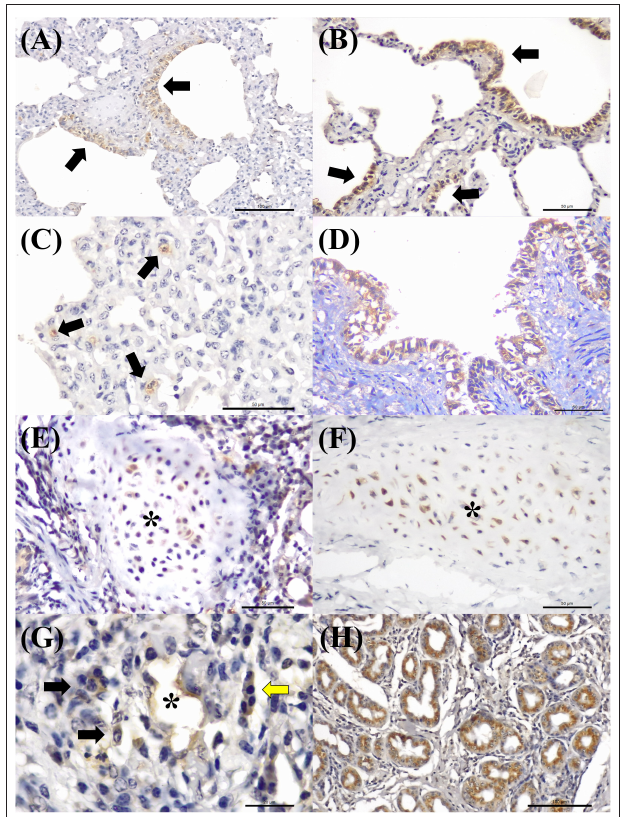
FIGURE 6 | Immunohistochemical identification of BRSV, BoHV-1, and BPIV-3 antigens in singular infections of cattle with bovine respiratory disease. (A) There is positive intracytoplasmic immunoreactivity to BRSV antigens within bronchial and (B) bronchiolar epithelial cells, (C) chondrocytes of the hyaline cartilage (arrow), and (D) alveolar macrophages (arrows). (E,F) Observe positive intracytoplasmic immunolabeling for BoHV-1 antigens within endothelial cells [ (E) , asterisk] and (G) chondrocytes of the hyaline cartilage. (H) There is positive intracytoplasmic immunoreactivity to BPIV-3 antigens within epithelial cells of the normal (arrows) and (I) vacuolized bronchiolar cells (asterisk). Immunoperoxidase counterstained with hematoxylin. Bar: (A,B,D–F,H) 20 µ m; (C,G,I) 50 µ